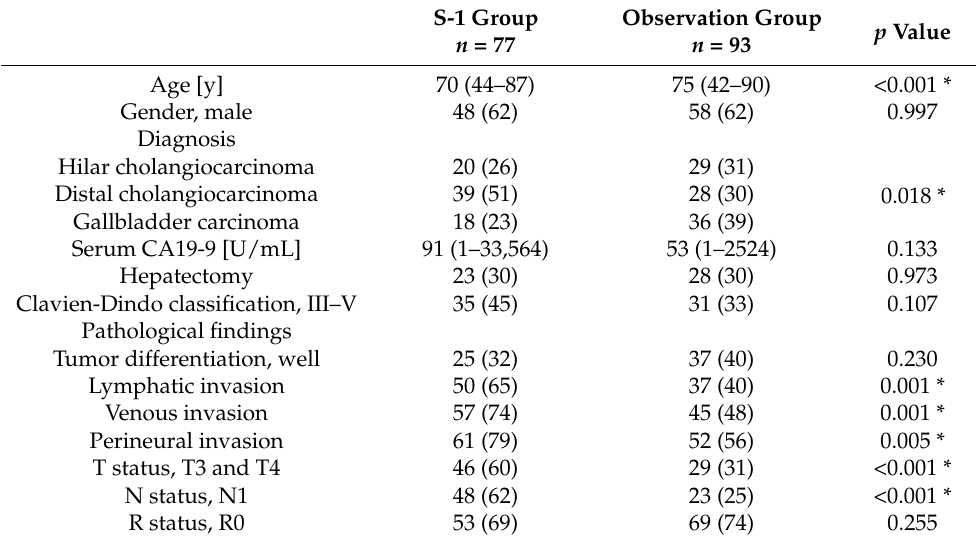
Table 1. Profiles and tumour characteristics of the patients in each group of the entire cohort. S-1 Group